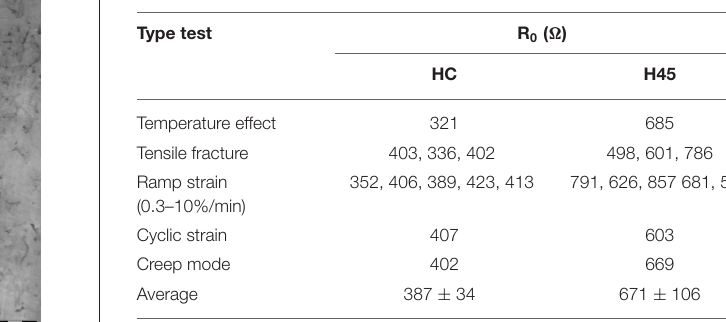
TABLE 1 | Summary of initial resistance values (R 0 ) at room temperature of the 3D-printed samples produced in HC and H45 configuration.